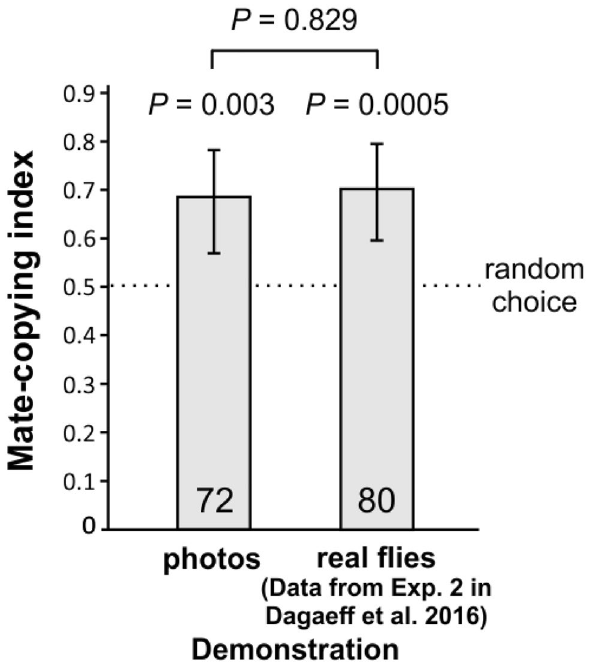
Figure 3. Mate-copying indexes with live or photo demonstrations. Number inside bars: number of trials. Statistics: above bars, P values of the binomial tests of departure from random choice (represented by the dashed line); the P value above the horizontal bar is that of the comparison between live and picture demonstrations (GLMM). Error bars represent Agresti-Coull 95% confidence intervals. For an example of the photos used see Fig. 2a.